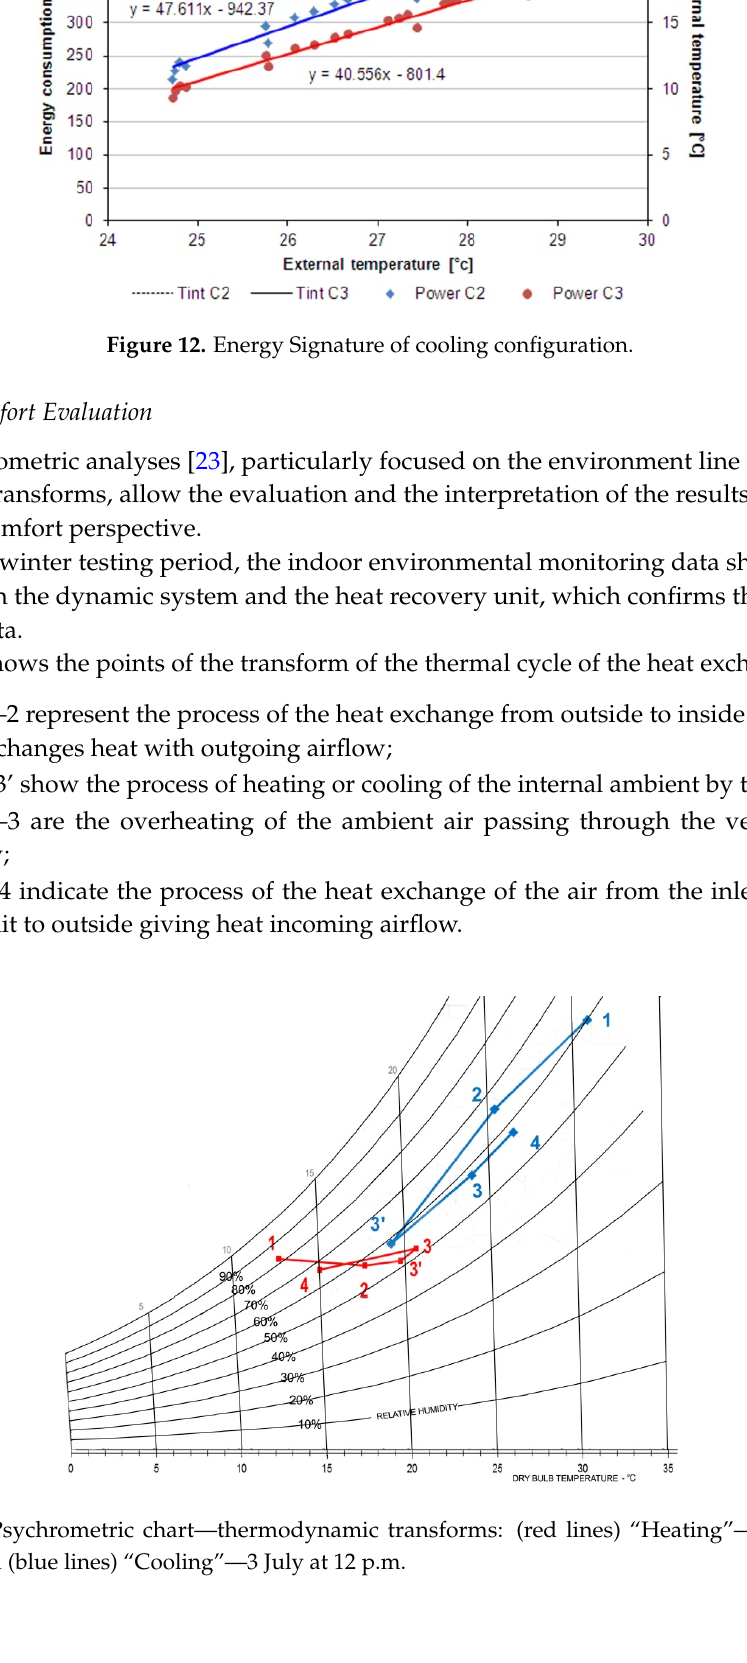
Figure 12. Energy Signature of cooling configuration.